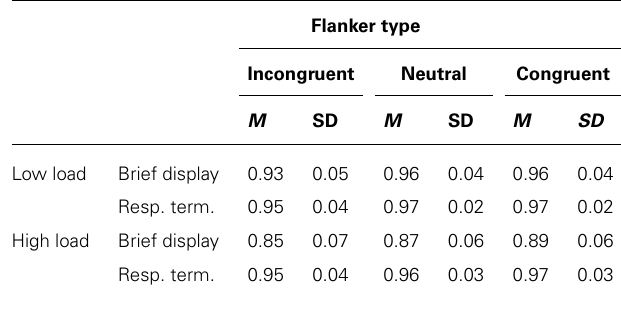
Table 1 | Experiment 1: accuracy